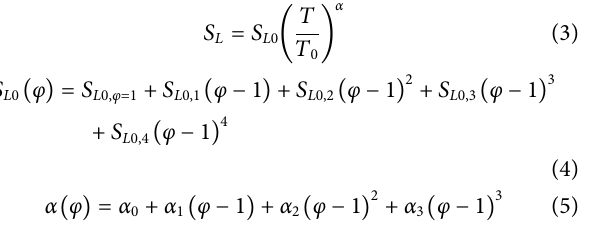
Frontiers in Energy Research |